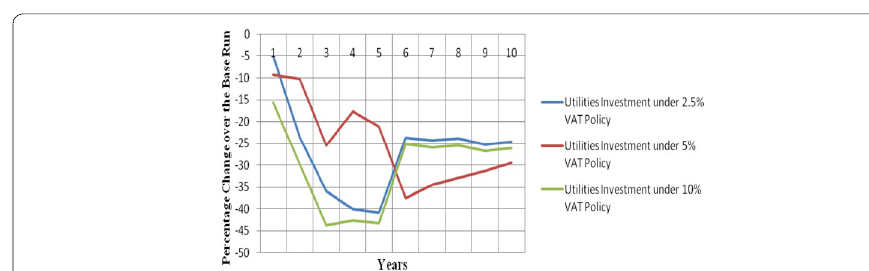
Fig. 25 Changes in utilities investment under varying VAT rates